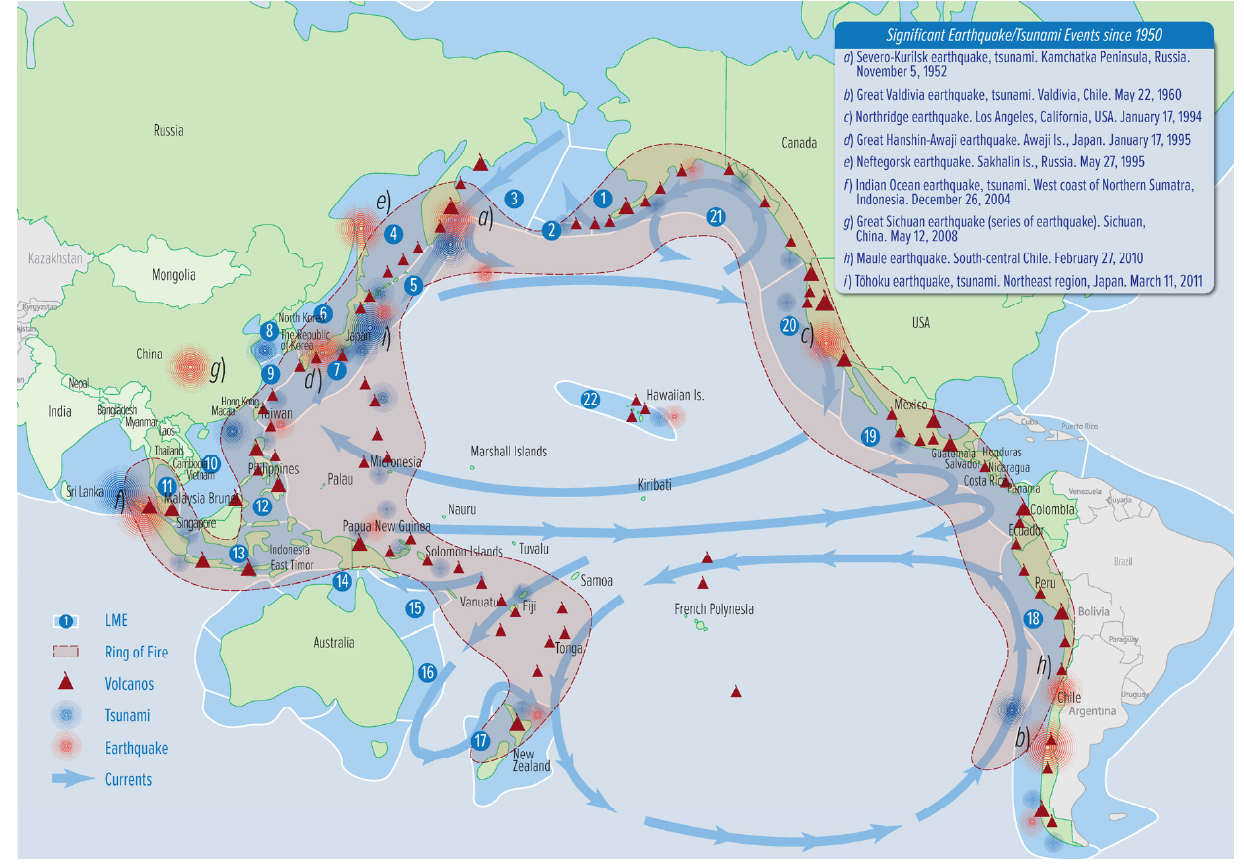
Figure 2. Natural synergy of the Asia-Pacific region (sources of data used: